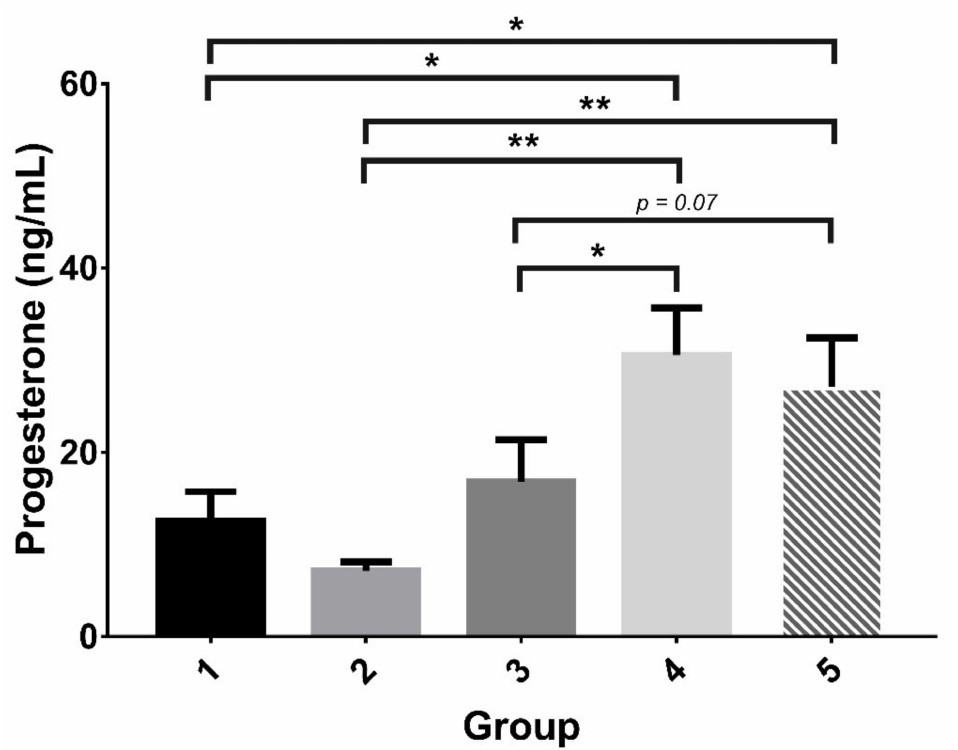
Figure 3. Serum progesterone levels in rats. The serum progesterone levels in the groups that received intermittent abdominal (G4) or vaginal (G5) s.c. injection of rhFSH were significantly higher than those in the groups that received daily abdominal (G2) or vaginal (G3) s.c. injection of rhFSH. The progesterone levels in the groups that received intermittent abdominal (G4) or vaginal (G5) s.c. injection of 4 IU rhFSH were significantly higher than that of the control (G1). G1: abdominal s.c. injection of normal saline twice daily for 4 days (days 1 to 4); G2: abdominal s.c. injection of rhFSH (1 IU) twice daily for 4 days (days 1 to 4); G3: vaginal s.c. injection of rhFSH (1 IU) twice daily for 4 days (days 1 to 4); G4: abdominal s.c. injection of rhFSH (4 IU) every other day (2 injections) (days 1 & 3); G5: vaginal s.c. injection of rhFSH (4 IU) every other day (two injections) (days 1 & 3). * p < 0.05, ** p <